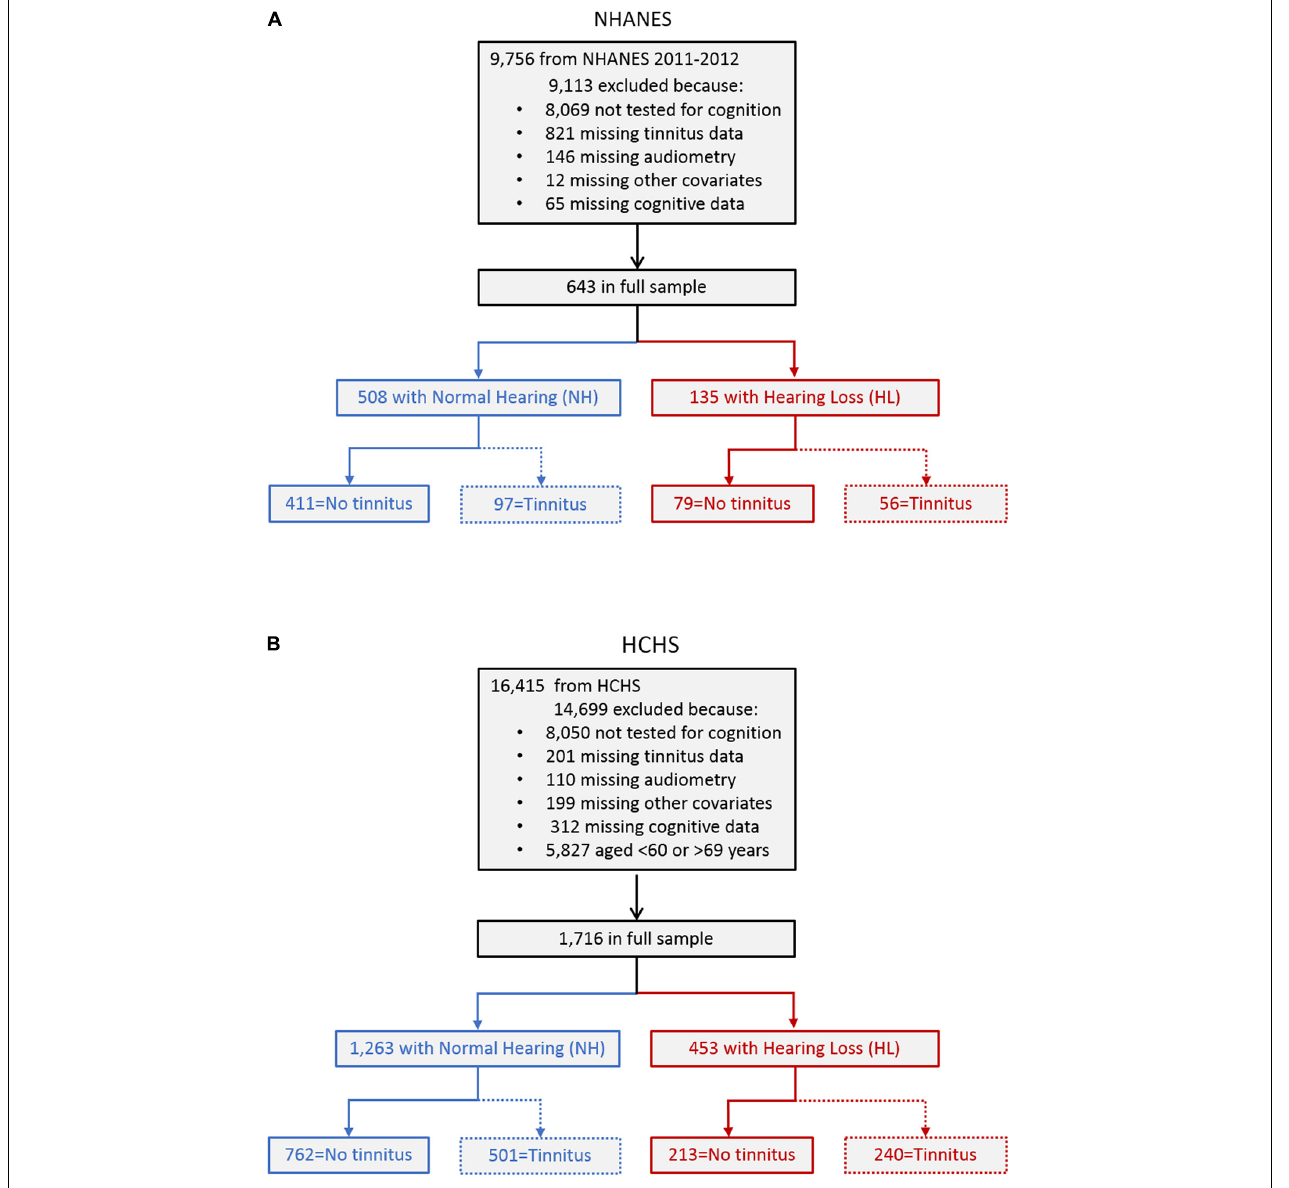
FIGURE 1 | Experimental design flowchart in the NHANES [panel (A) ] and HCHS (B)